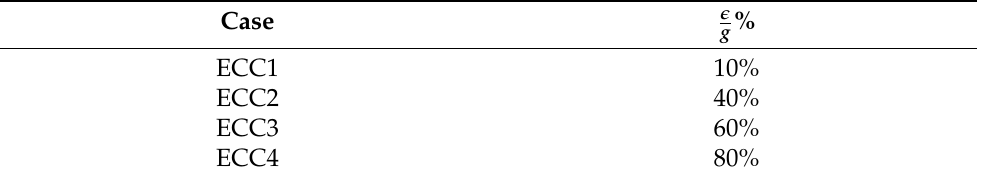
Table 4. Severity levels of static eccentricity fault.